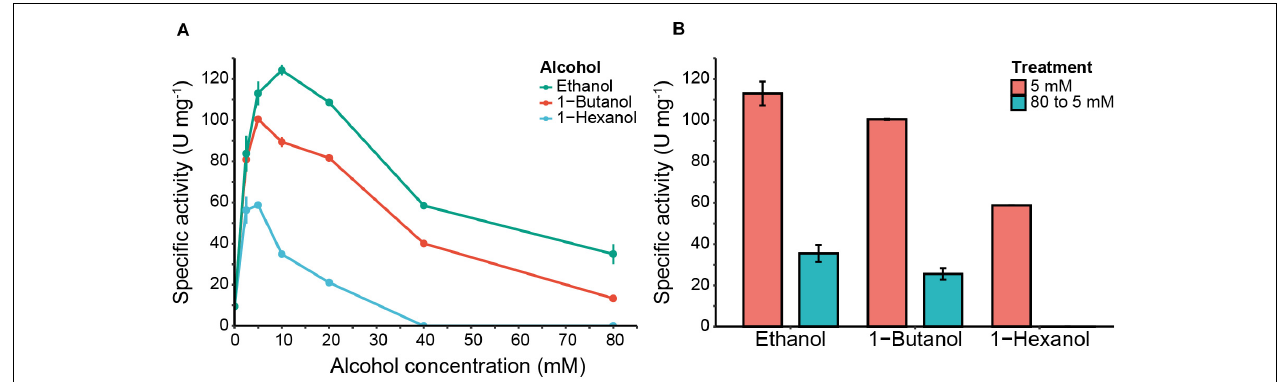
FIGURE 3 | 4-nitrophenol release and Eat1 inhibition assays in the presence of different alcohols. (A) 4-nitrophenol release by Eat1 was measured colorimetrically using 100 µ M 4-nitrophenyl acetate and different concentrations (0–80 mM) of ethanol (blue line), 1-butanol (red line) or 1-hexanol (green line). (B) Inhibition of Eat1 was assessed by exposing Eat1 to 80 mM of ethanol, 1-butanol or 1-hexanol and immediately diluting it to 5 mM final concentration (blue bars). The release of 4-nitrophenol was monitored and compared with an assay where pre-treatment of Eat1 with 80 mM alcohols was omitted (red bars). Error bars indicate the standard deviation. 1 U = 1 µ mol min - 1